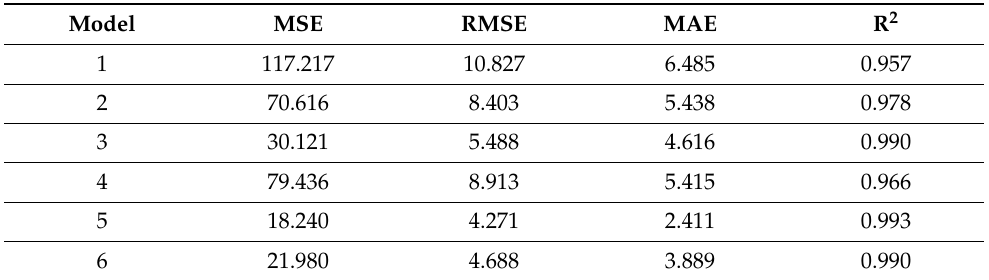
Table 8. Model validation results of set 3 for the slurry test with RETAINED_PRM as the output.